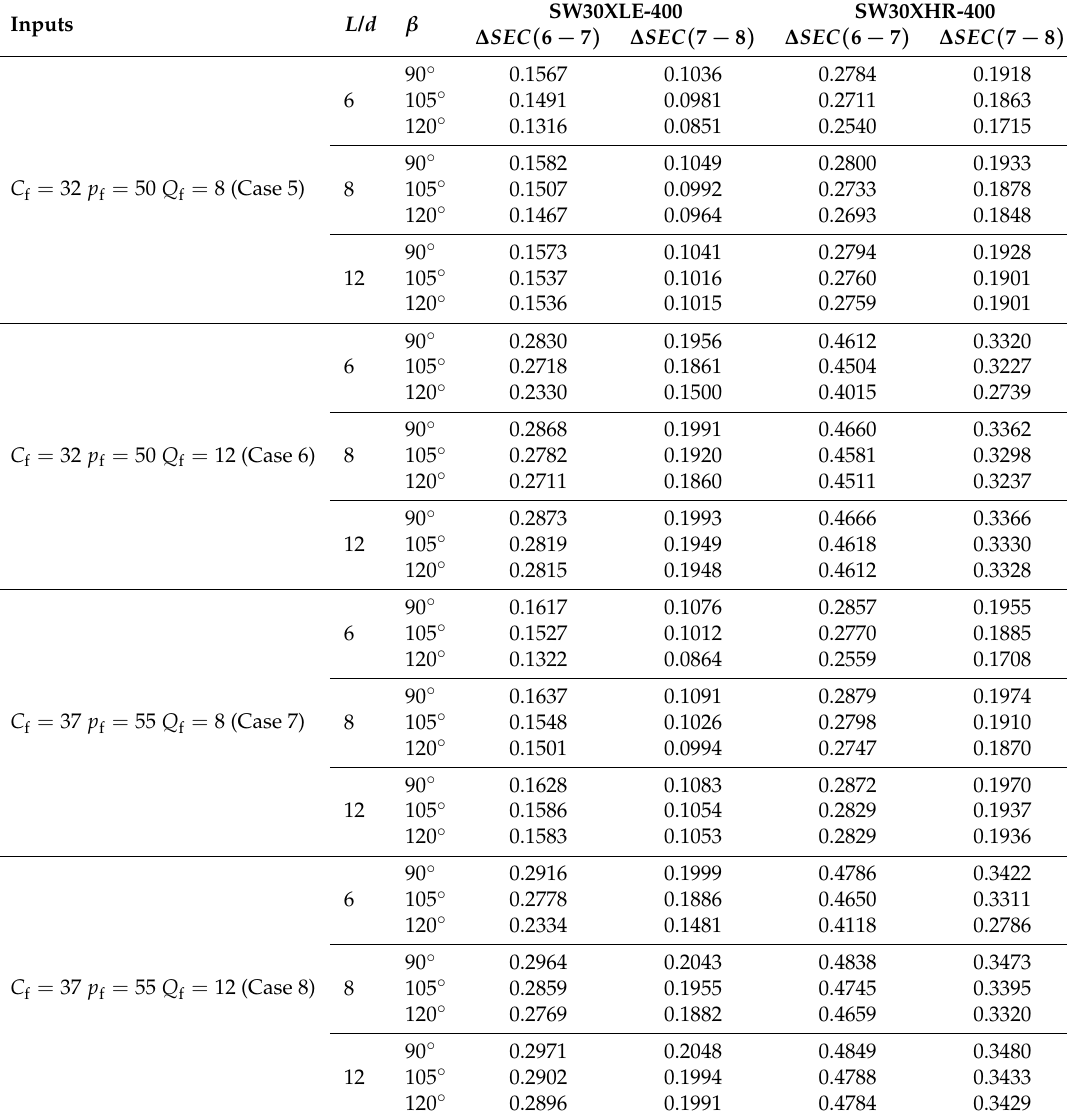
Table 7. ∆ SEC (kWh m − 3 ) between PVs of 6 and 7 ( ∆ SEC ( 6 − 7 ) ), and 7 and 8 ( ∆ SEC ( 7 − 8 ) ) SWMMs for the two membranes studied with different